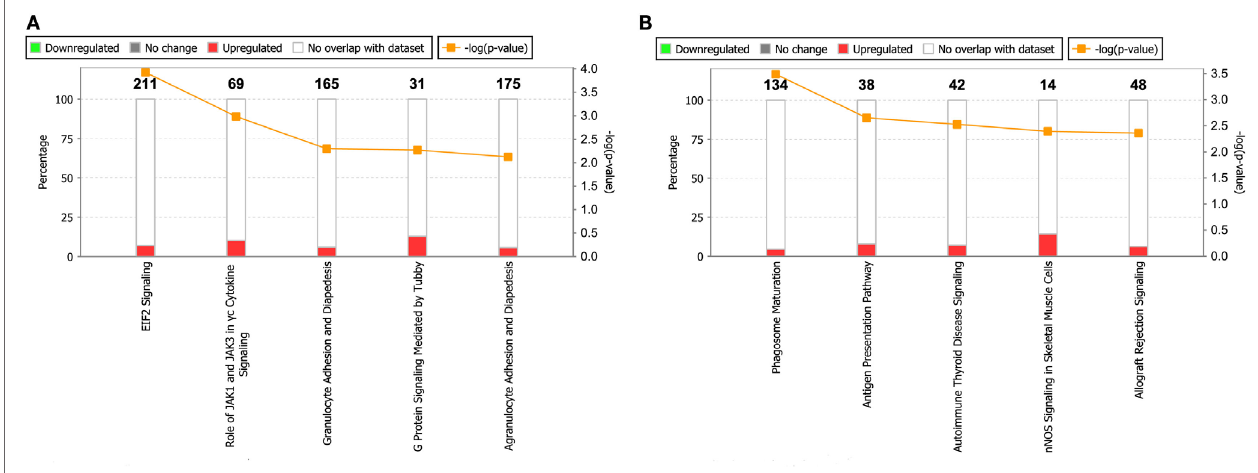
FigUre 6 | Top five enriched pathways for ROP18 I (a) and ROP18 II (B) interacting proteins. The stacked bar chart indicates the number of proteins overlapped with the database, and the connected orange points represent the logarithm of the p